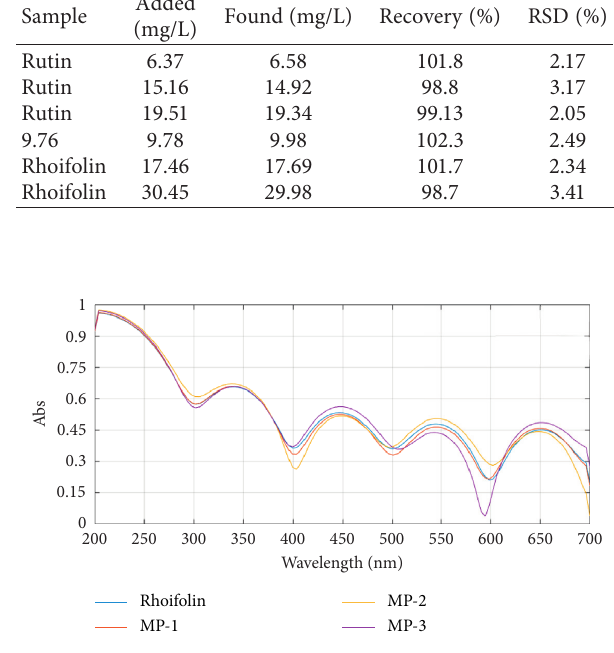
Figure 2: The UV-vis spectra of MP-1, MP-2, and MP-3 after adsorption of the drug model rutin and